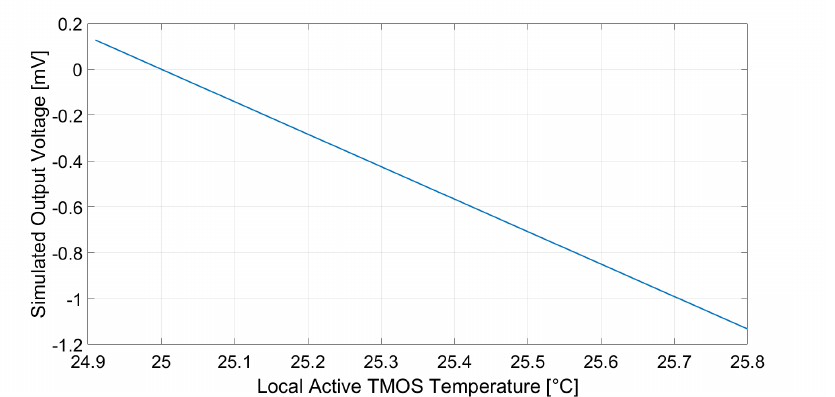
Figure 4. Simulated 2–T configuration TMOS sensor output voltage. Cadence Virtuoso was employed as simulation software.